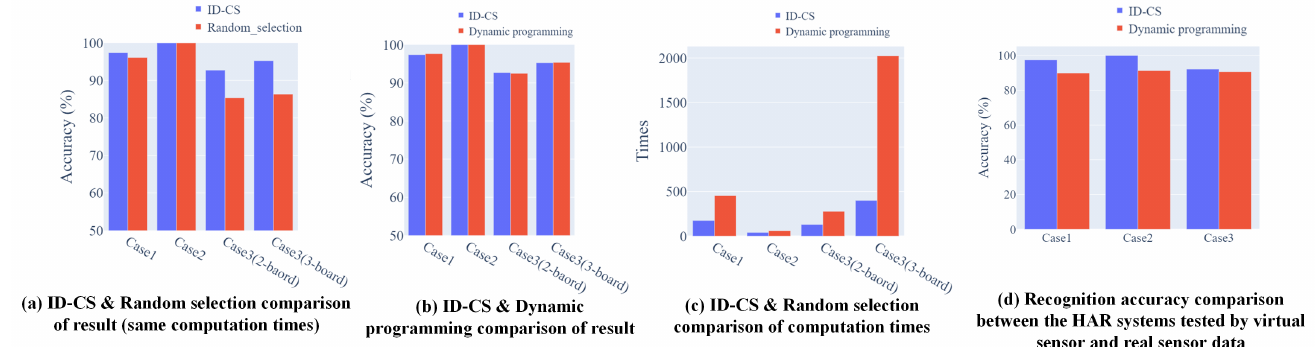
Figure 13. The optimization method comparison in terms of accuracy and computation times; ( a ) result comparison—ID-CS vs. random selection under the same computation cost (highest accuracy reached by ID-CS); ( b ) result comparison—ID- CS vs. dynamic programming (a few differences between ID-CS and DP); ( c ) computation times comparison—ID-CS vs. dynamic programming (less computation cost than ID-CS); and ( d ) accuracy comparison of virtual sensor vs. real sensor